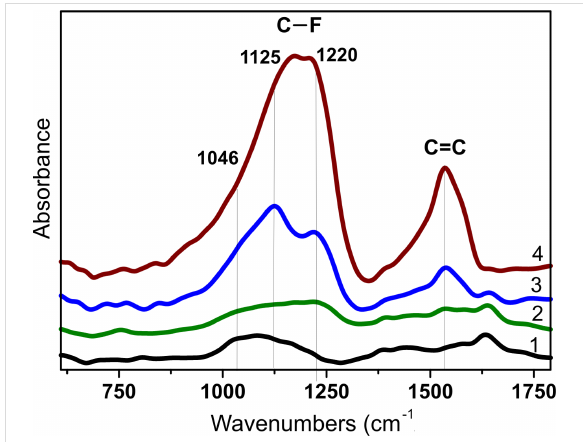
Figure 6: IR spectra of pristine DWCNTs (1) and DWCNTs fluorinated with CF 4 plasma (2), BrF 3 (3), and F 2 (4).